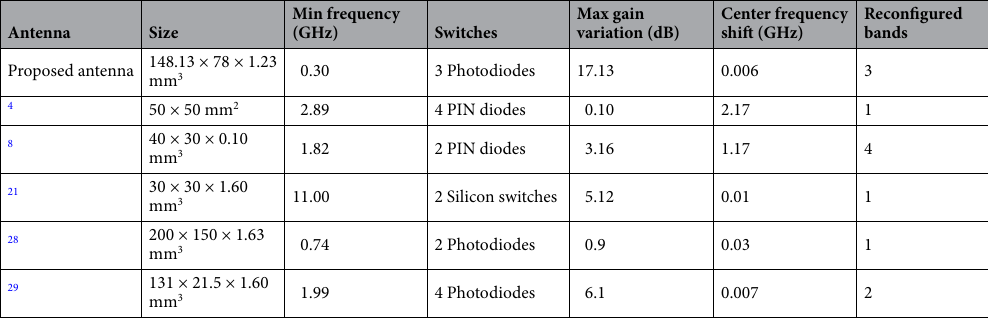
Table 6. Comparison between other reconfigurable antennas and the proposed